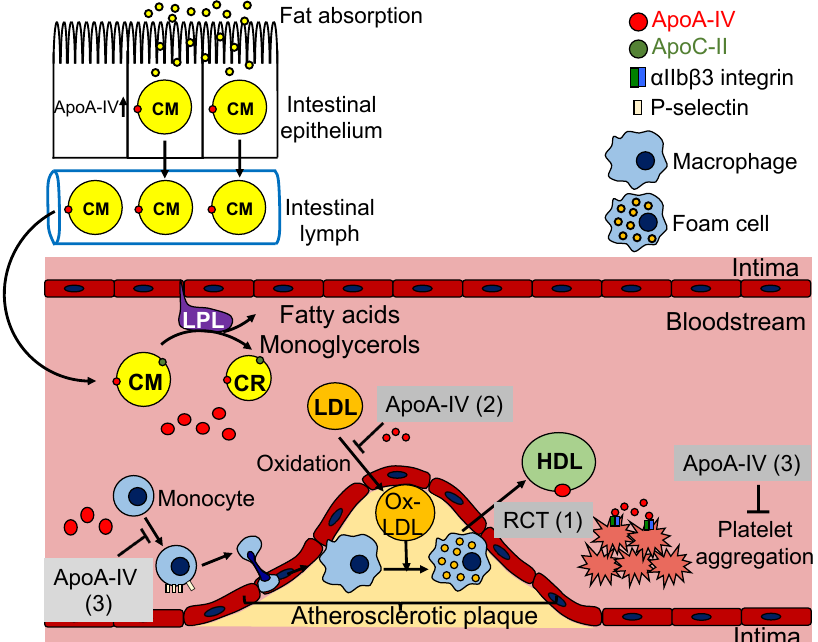
Figure 1. The metabolism of apoA-IV-containing lipoproteins and possible anti-atherogenic mechanisms related to apoA-IV. Upon fat absorption, apoA-IV is synthesized, secreted together with chylomicrons (CM) and transported via lymphatic system to bloodstream. In the circulation, apoA-IV promotes the activity of lipoprotein lipase (LPL) in the presence of apoC-II. Most apoA-IV dissociates from chylomicron remnants (CR) and 25% of them are transferred to high-density lipoproteins (HDL), while the rest are circulating in lipid-free state. (1) ApoA-IV is involved in reverse cholesterol transport, likely by activating LCAT activity and facilitating cholesterol transport from foam cells or other peripheral cells to HDL. (2) ApoA-IV can reduce the production of oxidized low-density lipoprotein (Ox-LDL), which is constantly taken up by macrophages to form foam cells. (3) ApoA-IV acts as anti-inflammatory agent likely by suppressing P-selectin-mediated leukocyte and platelet adhesion to endothelial cells. It also interacts with α IIb β 3 integrin and inhibits platelet